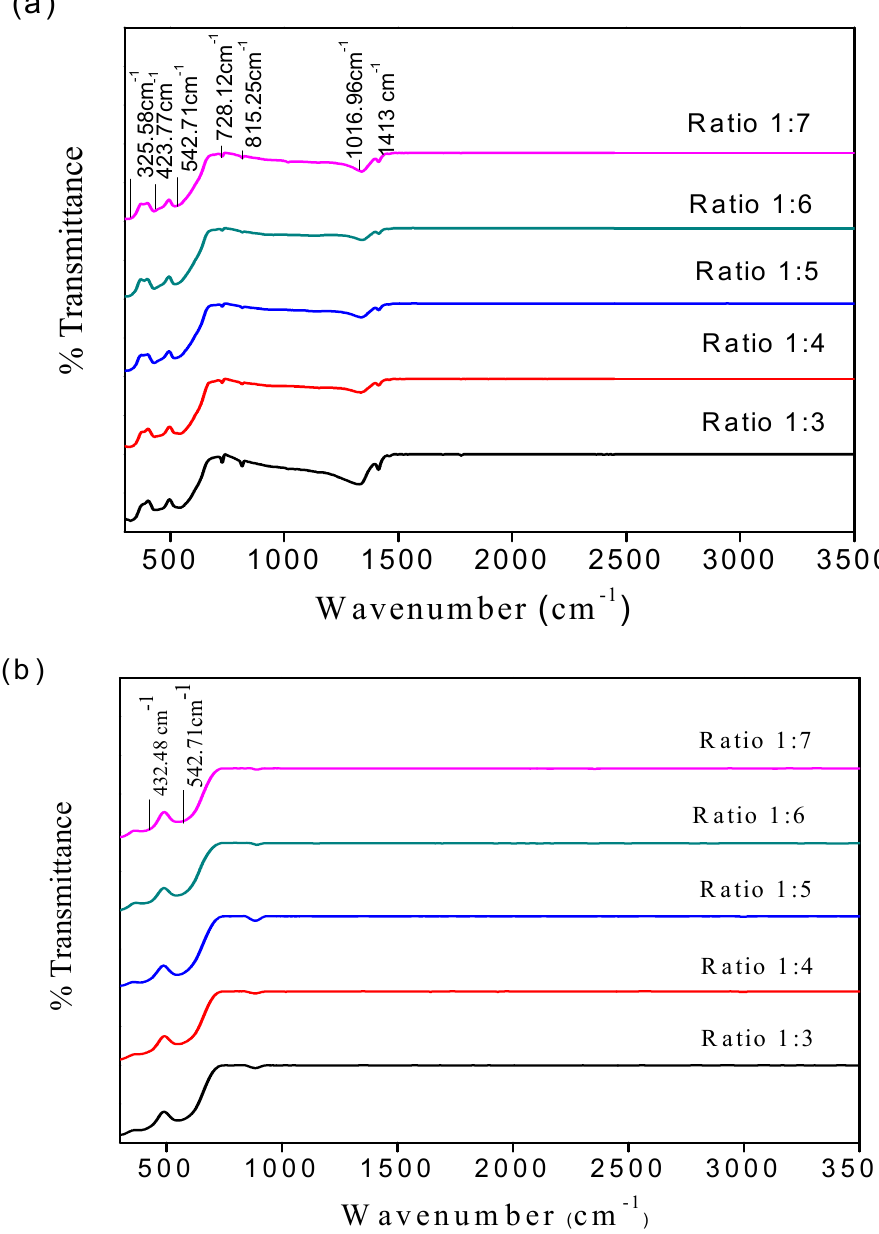
Figure 3. FTIR of BaFe 12 O 19 ( a ) before sintering and ( b ) after sintering at 1300 °C.